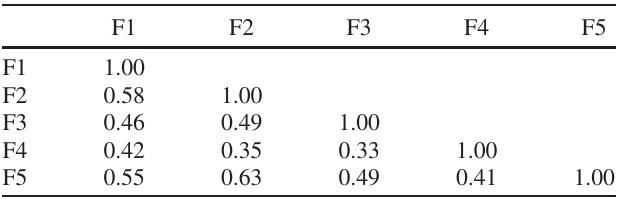
only the lower left corner is